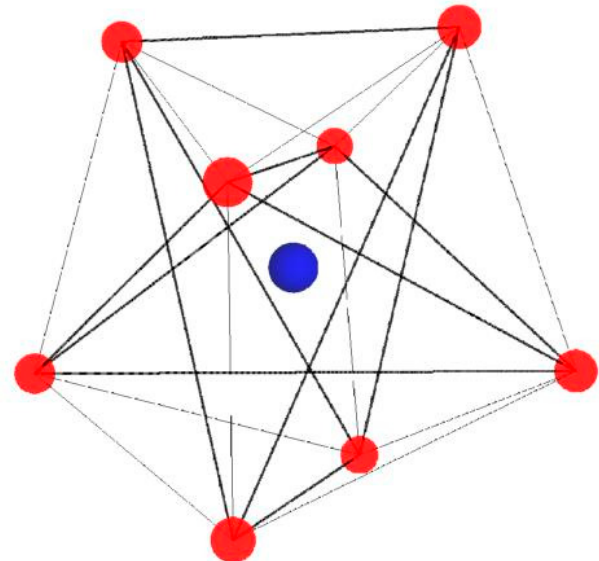
Figure 2. Fragment of the barium tungstate (BWO) cell structure: dodecahedron [BaO 8 ] consisting of two rotated tetrahedra.